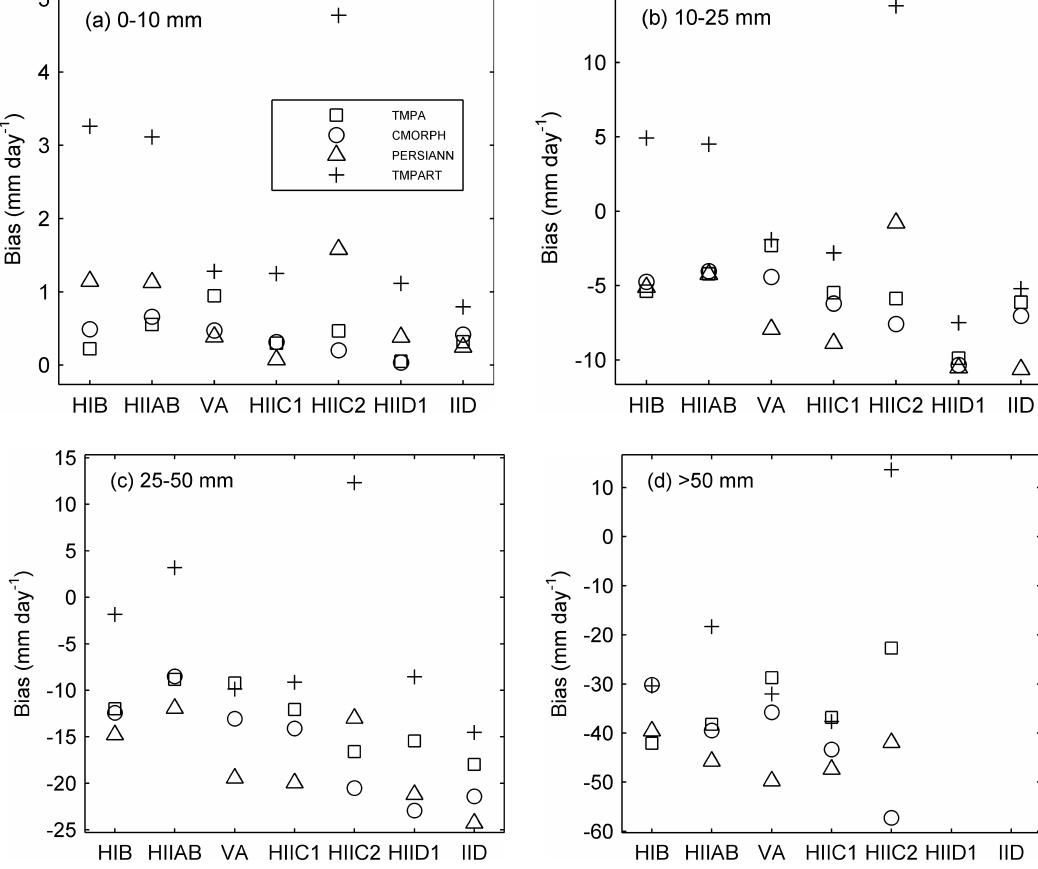
Fig. 7. Bias of satellite-based precipitation products for different rainfall